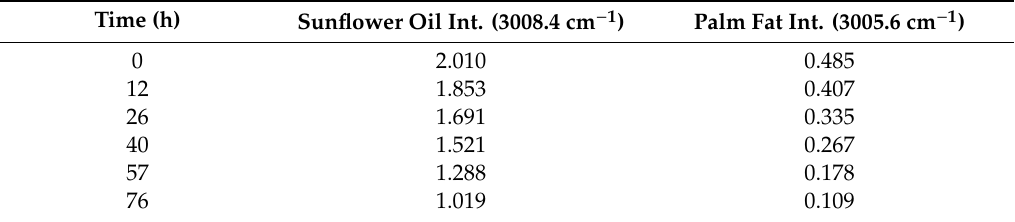
Table 4. Integral of the infrared absorption band of cis double bonds of the fatty acids of sunflower oil and palm fat, with dependence on the time of thermo-oxidative